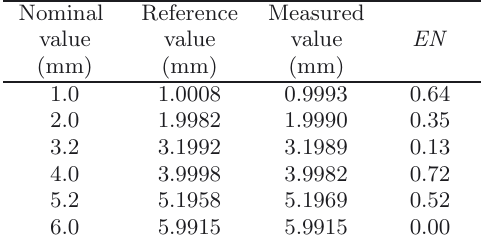
Table 3. Validation of the results for the image registration method of the 6 mm